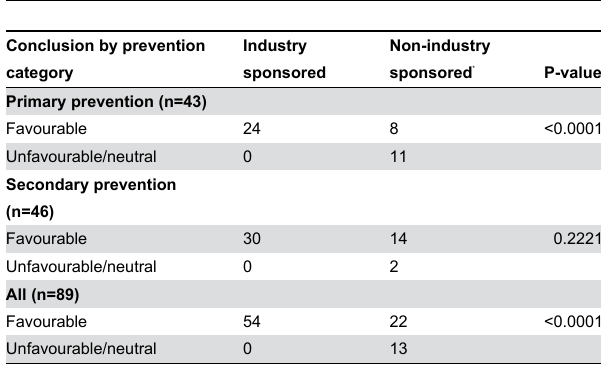
Table 4. Study conclusions by funding source.